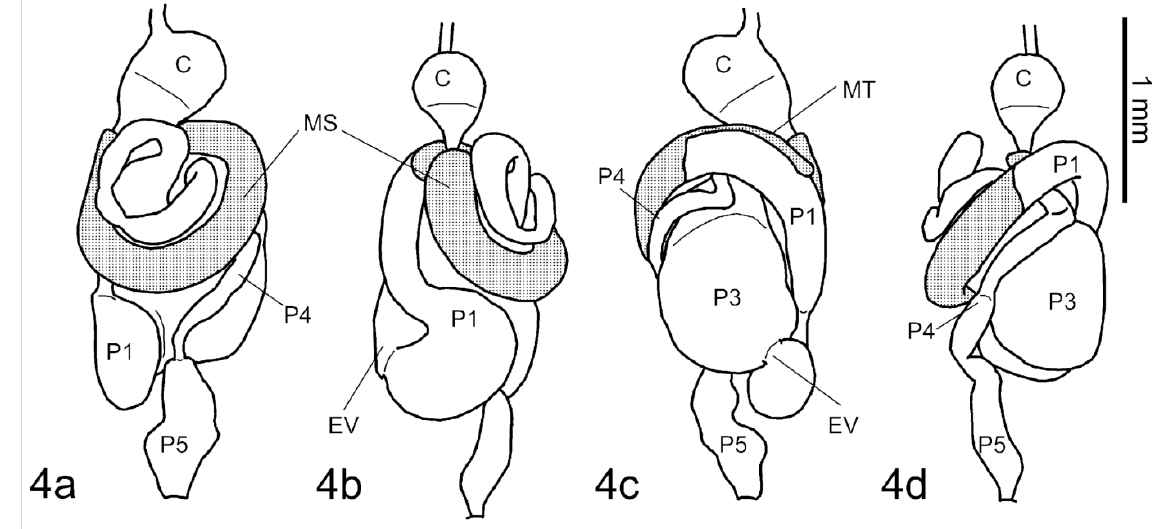
Fig 4 . Digestive tube of Pericapritermes ceylonicus (Holmgren) worker: a) dorsal; b) left; c) ventral; and d) right views; C: Crop; MS: Mesenteric segment; MT: Mesenteric tongue; P1: First proctodeal segment (ileum); P3: Third proctodeal segment (paunch); P4: Fourth proctodeal segment (colon); P5: Fifth proctodeal segment (rectum).